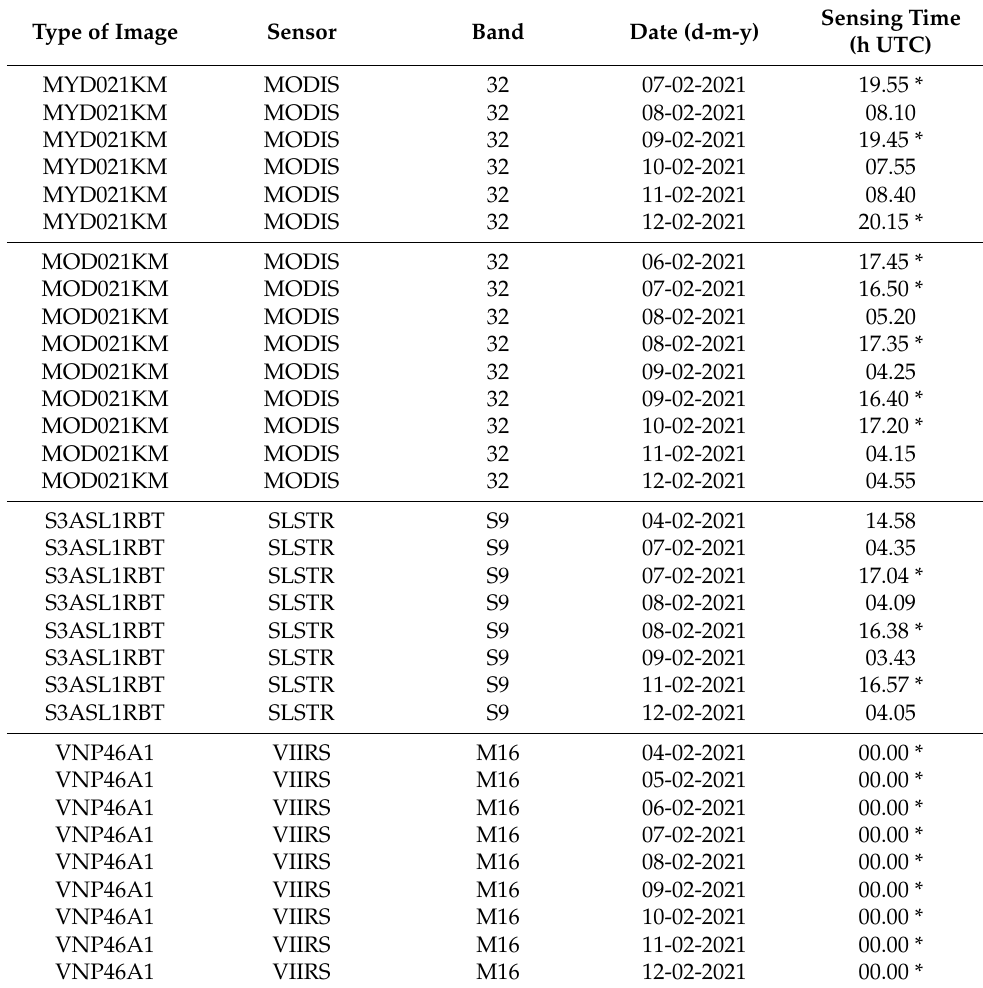
Table 2. Spaceborne imagery acquired from the LEO satellites for this study. The hours marked with an asterisk indicate nighttime satellite